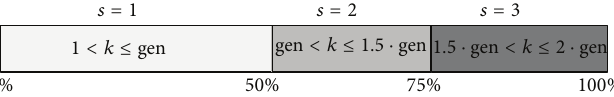
Figure 1: Division of the evolution process according to